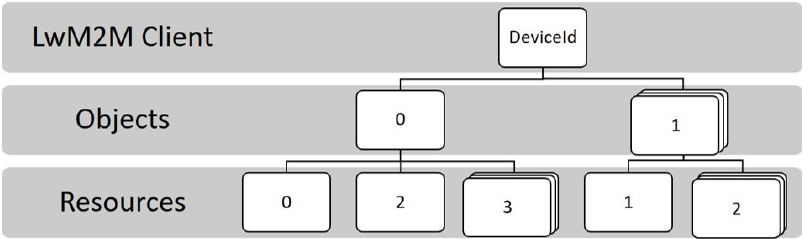
Figure 1. OMA LwM2M data model.